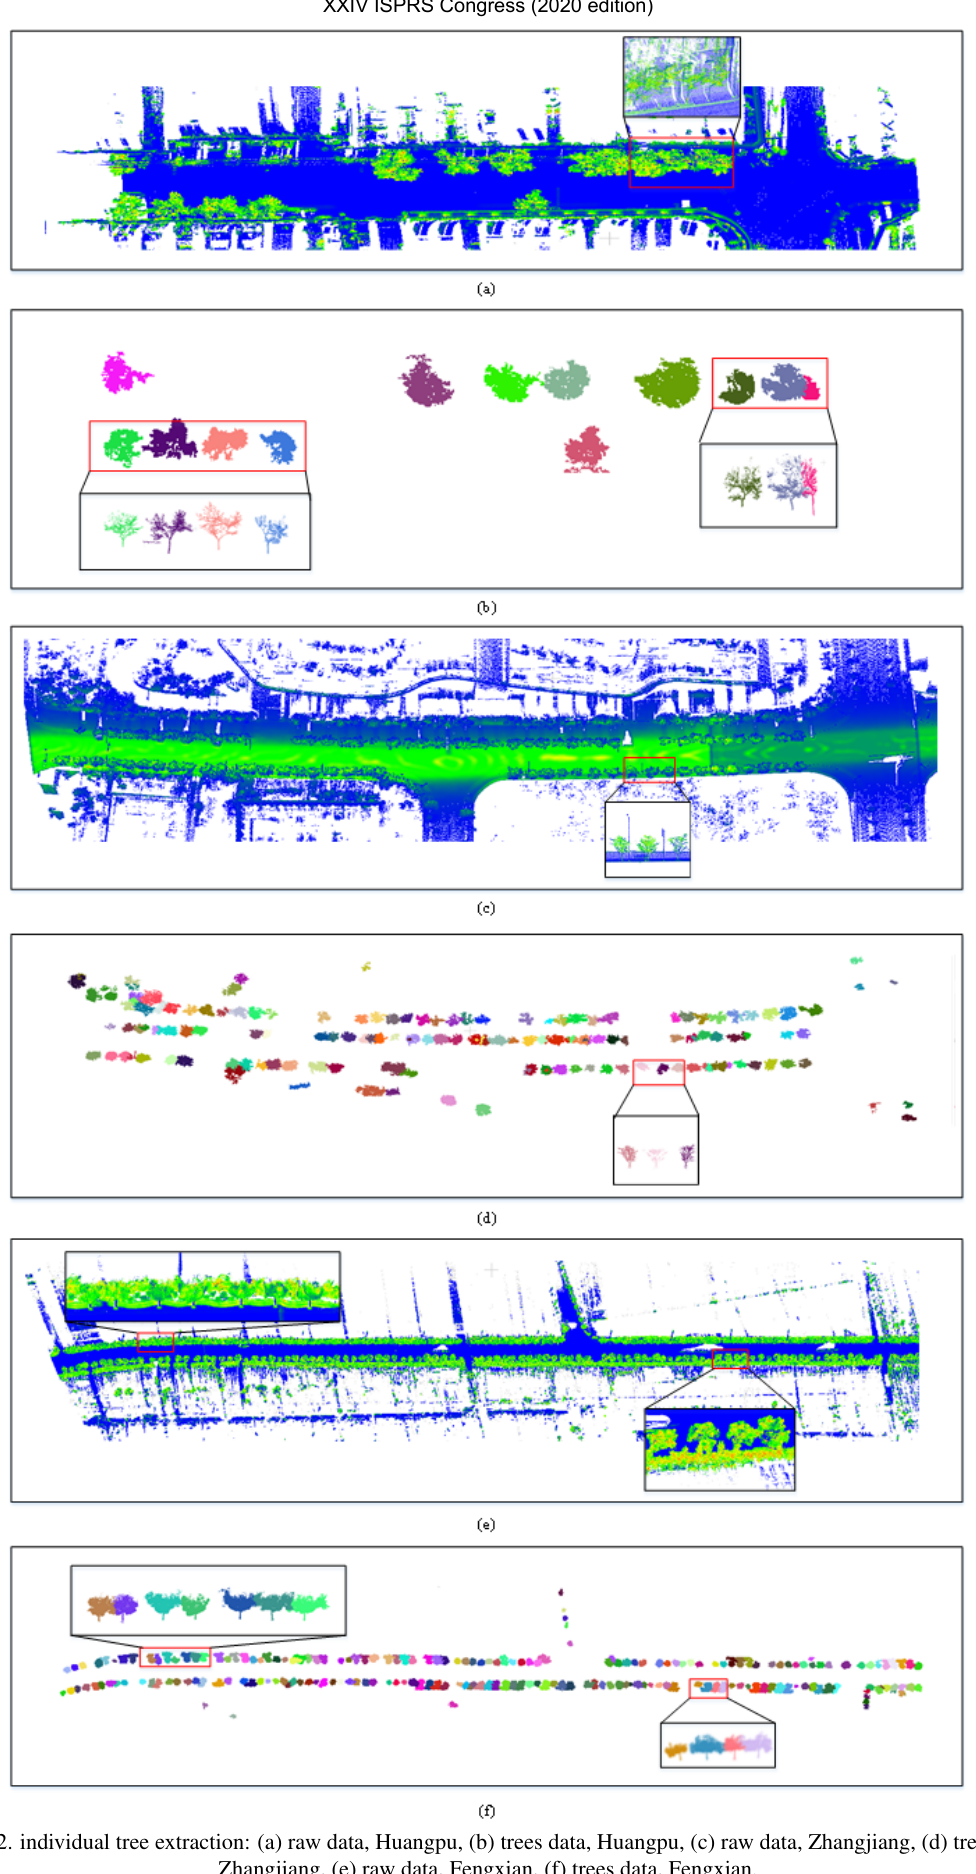
Figure 2. individual tree extraction: (a) raw data, Huangpu, (b) trees data, Huangpu, (c) raw data, Zhangjiang, (d) trees data, Zhangjiang, (e) raw data, Fengxian, (f) trees data,